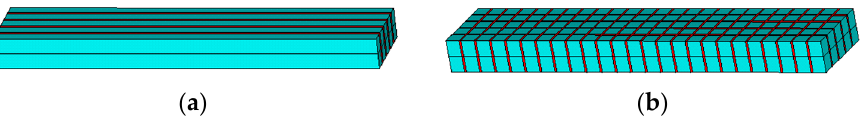
Figure 4. Finite element models of the 2-2 and 1-3 piezoelectric composite bilaminated vibrators. ( a ) 2-2. ( b ) 1-3. Table 1. Material parameters of the piezoelectric ceramics and epoxy resins Parameters